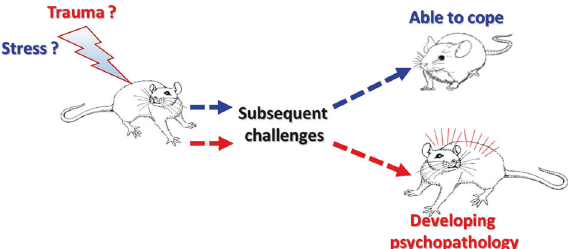
Fig. 1 Schematic illustration addressing the need for a conceptual terminology to allow the distinction between Stress and Trauma. As of now, there are no ideal ways for effectively addressing the subjective nature of the response to stress, the murkiness of the border between stressful and traumatic experiences, and the complexity of individual variability. Nevertheless, we propose to conceptually associate the term ‘ stress ’ / ‘ stressful experience ’ with ‘ stress resilience ’ (the ability to be exposed to a stressful experience and cope with it), while restricting the use of the term ‘ trauma ’ only in reference to exposures that lead to pathology. In accordance with that, additional tools and approaches should be developed, making it more practical to establish the distinction between Stress and Trauma. These would enable to more effectively dissociate neural mechanisms underlying coping with stress from those mechanisms underlying failure to cope, which lead to the development of trauma-related